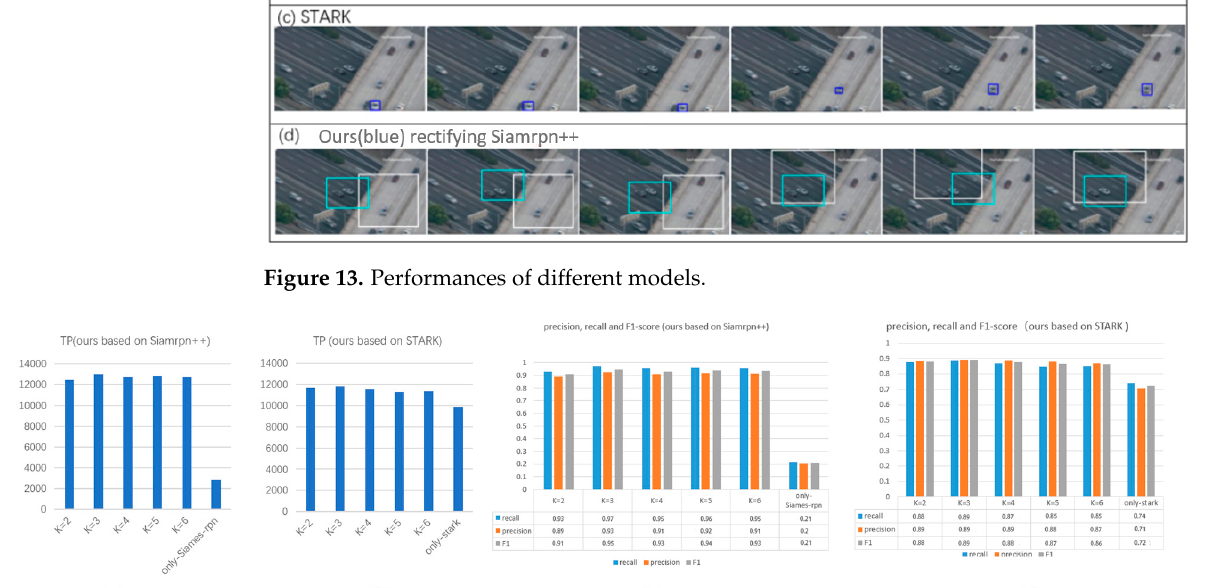
Figure 14. Test results of models under di ff erent K values.